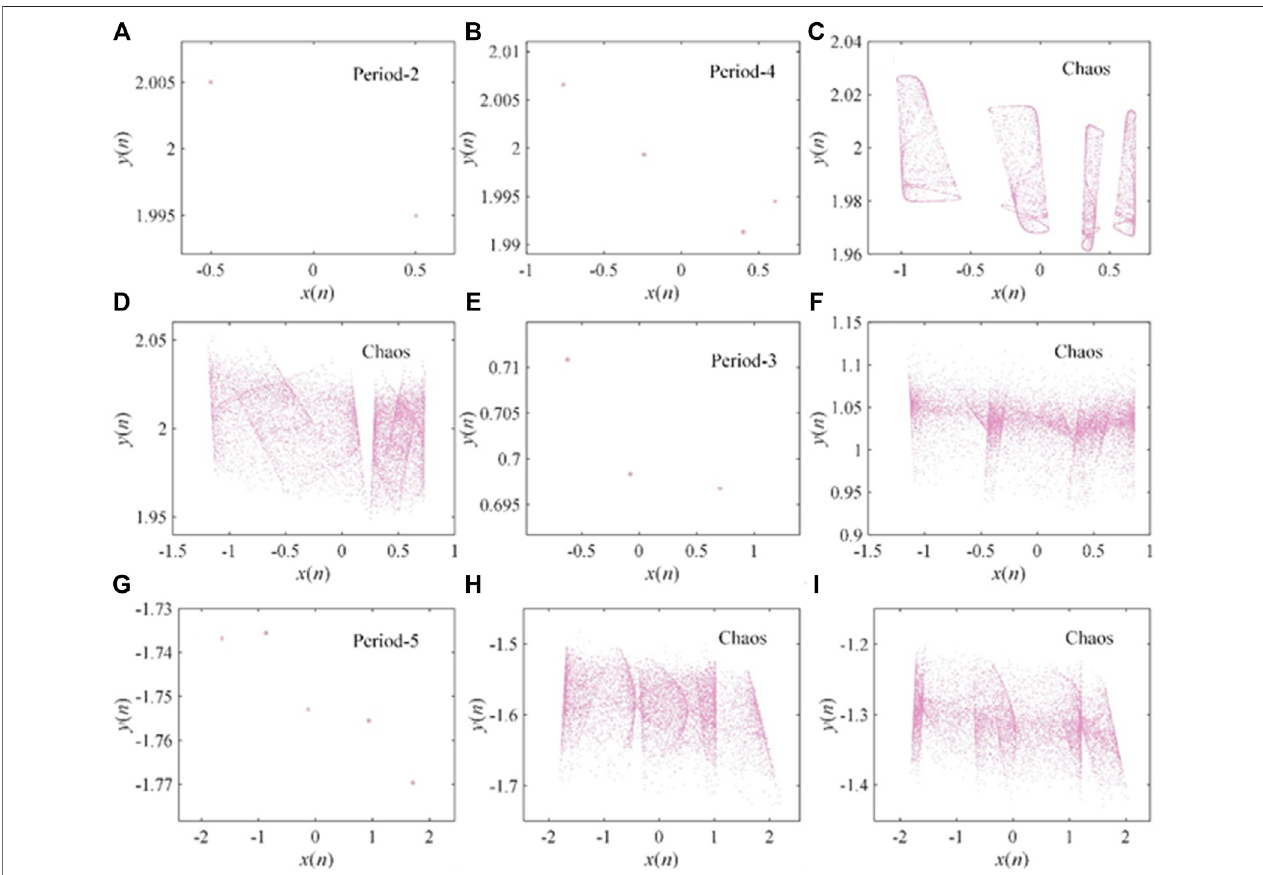
FIGURE4| Thephasespacemotiontrajectoryofthisdiscrete system. (A) a =0.3; (B) a =0.5; (C) a =0.6; (D) a =0.65; (E) a =0.7; (F) a =0.85; (G) a =0.9; (H) a = 1; (I) a = 1.2.